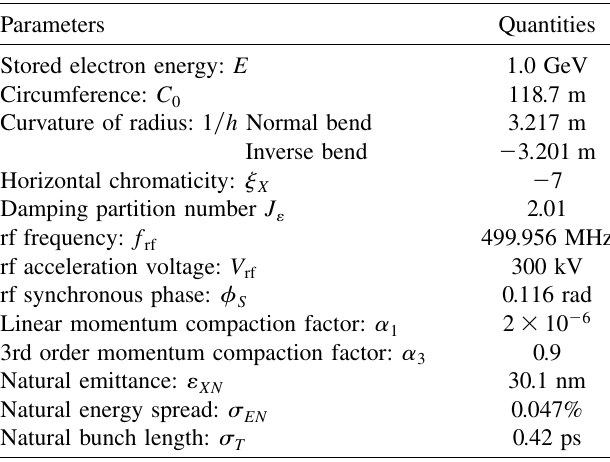
TABLE I. Main parameters of NewSUBARU at QI